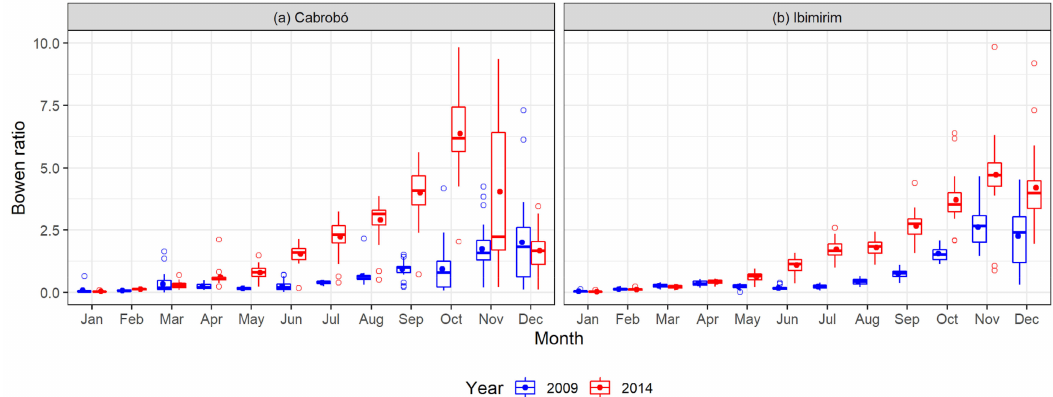
Figure 9. Monthly boxplots of hourly simulated Bowen ratio (ratio between sensible heat flux and latent heat flux) in the Cabrob ó and Ibimirim sites in 2009 (wet year) and 2014 (dry year).